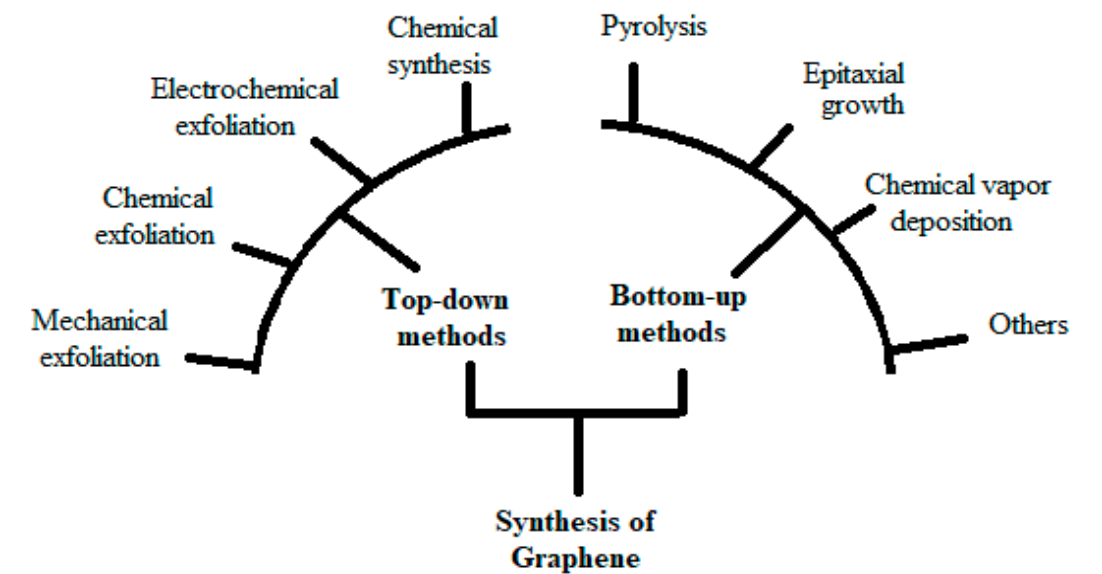
Figure 1. Flow chart for Gp synthetic routes. Reproduced with permission from [52]. Copyright ACS Publications, 2018.